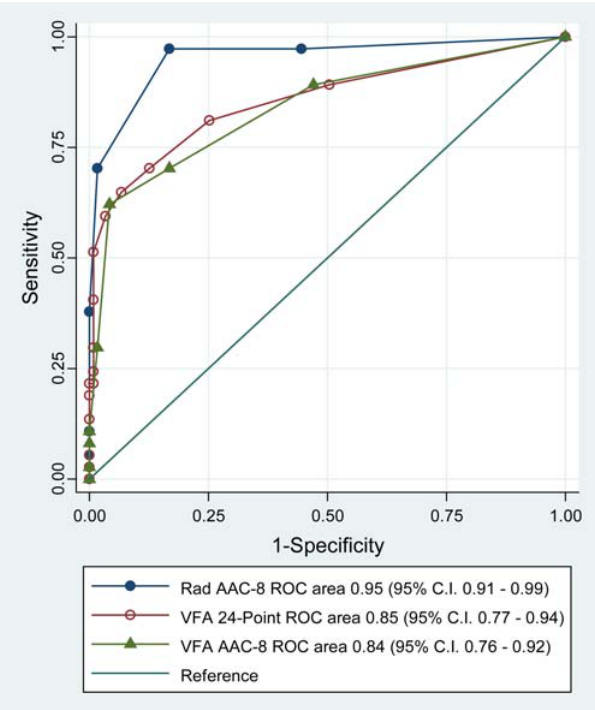
Figure 3. Receiver Operating Curve (ROC) Areas for Detection of Those with a Radiographic 24-point AAC score of 5 or